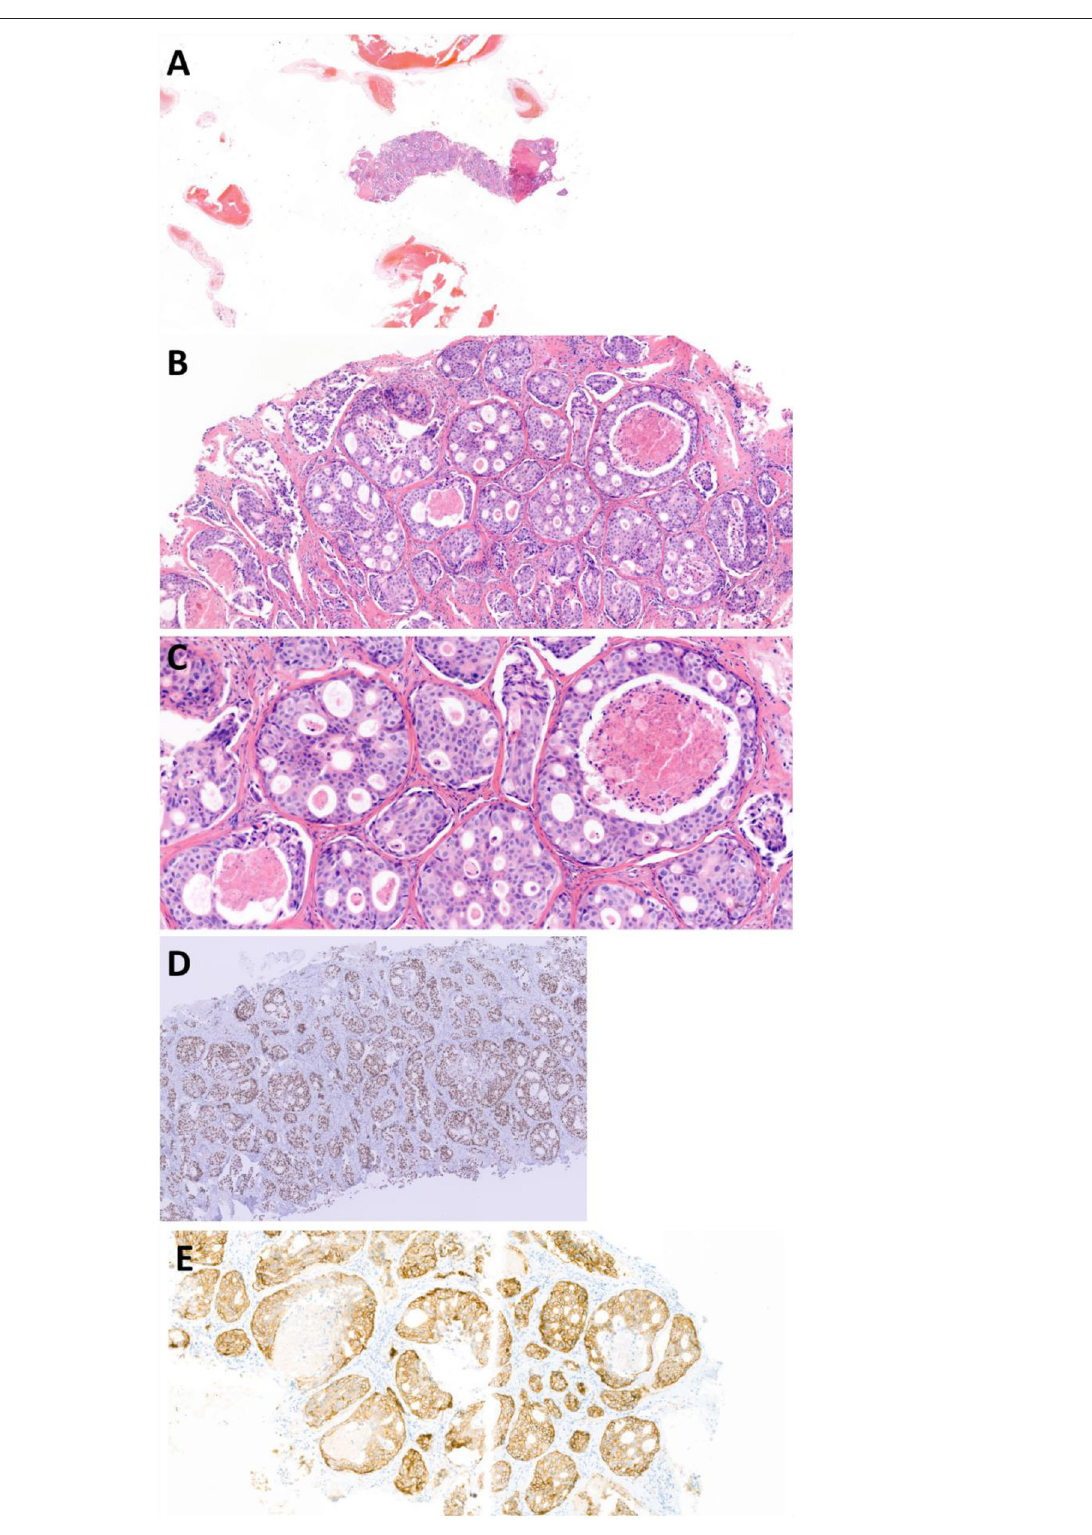
Frontiers in Medicine |